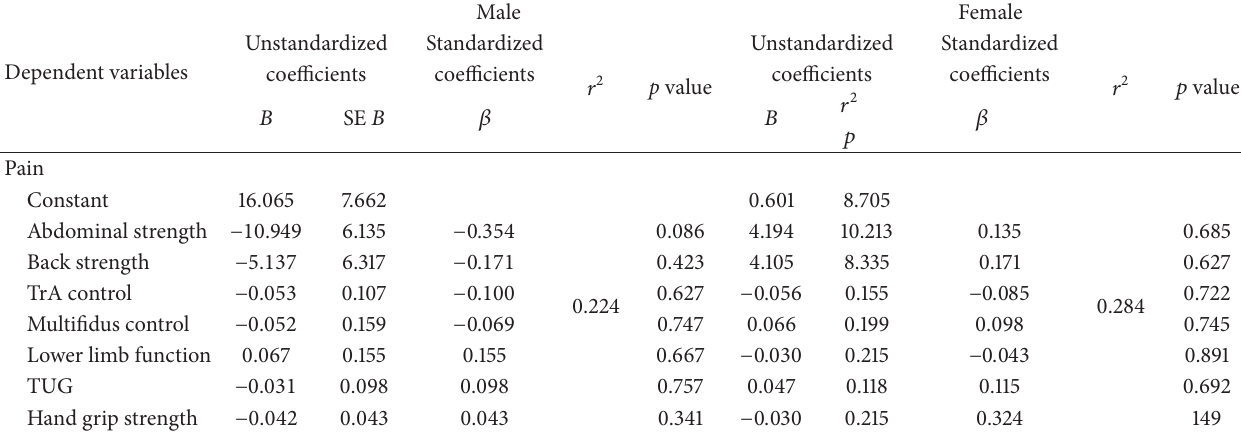
Table 4: Multiple linear regression of pain, muscle functions, and functional